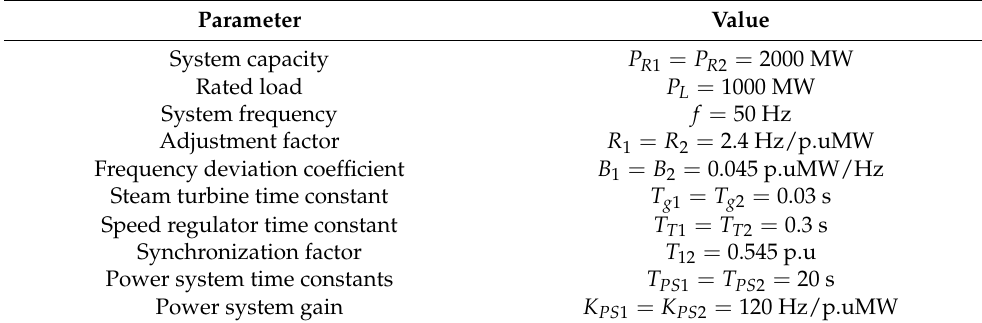
Table 2. Two-zone power system model parameters.